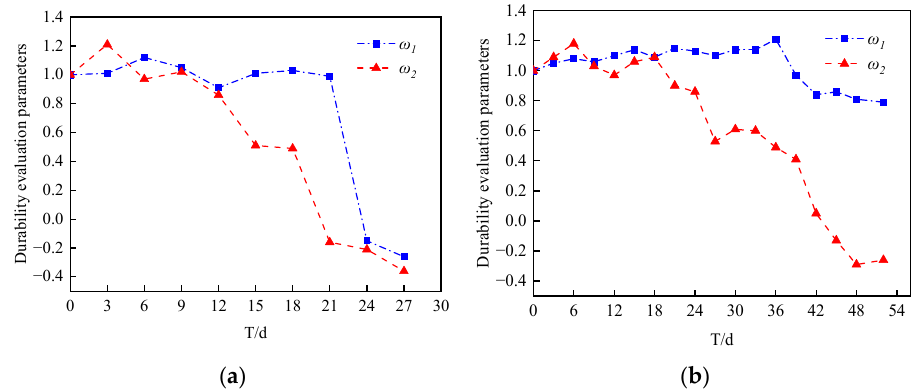
Figure 2. Durability evaluation parameters of MOCRC. ( a ) Group A. ( b ) Group B.